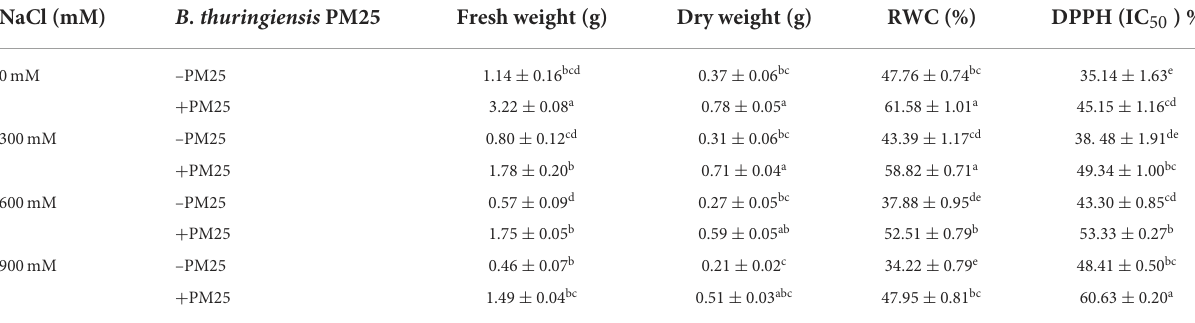
TABLE 3 Biomass, leaf surface area, relative water content, and antioxidant activity of maize in the presence and absence of Bacillus thuringiensis PM25 under salinity stress.